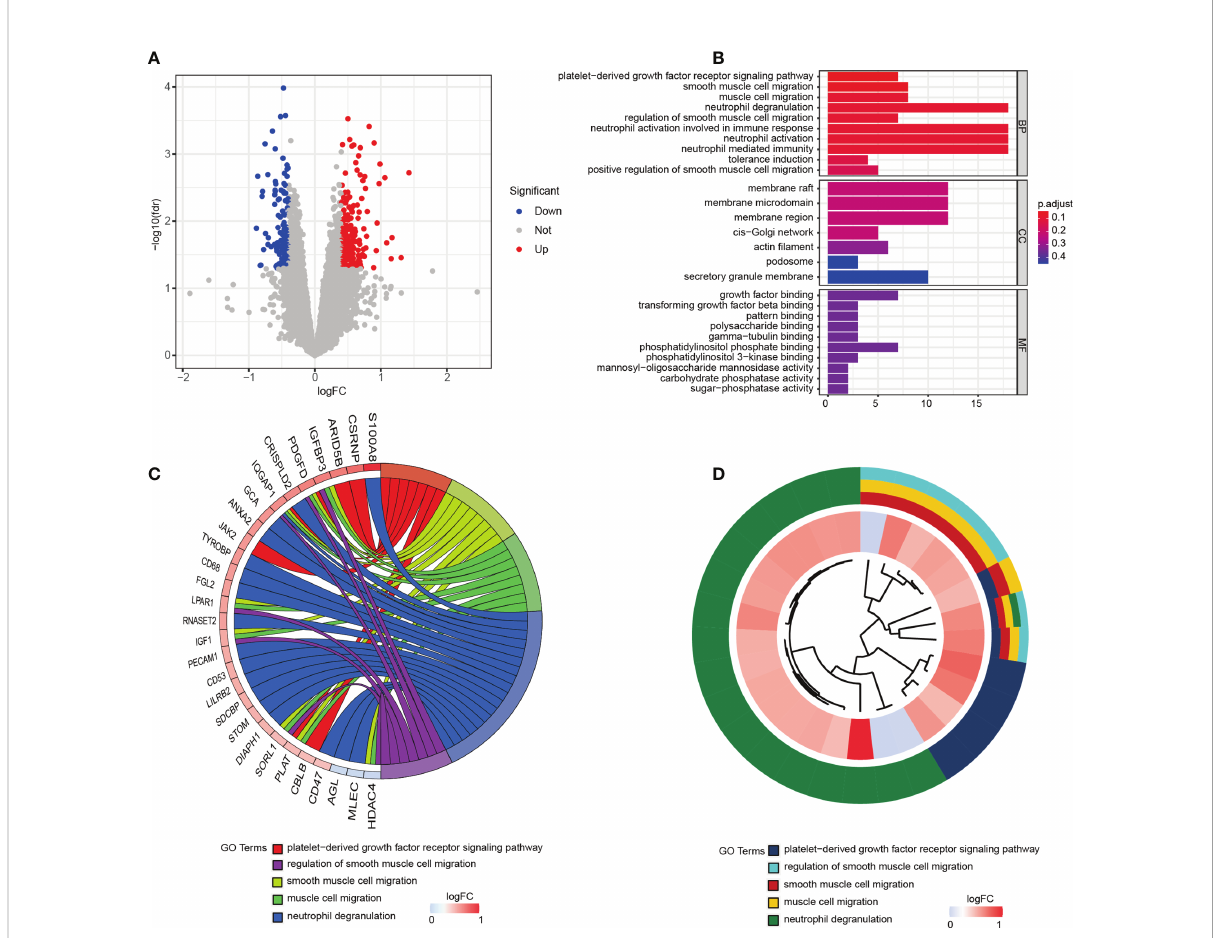
FIGURE 1 324 DEGs were identi fi ed as being statistically signi fi cant between groups. (A) Volcano plot of DEGs. (B) GO functional enrichment analysis of DEGs. (C) Top 5 GO terms and related genes. (D) Top 5 GO terms.